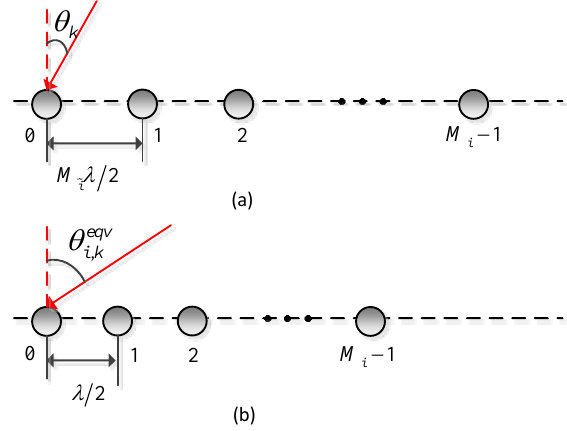
Figure 2. The System model of ( a ) the i th subarray and ( b ) its corresponding equivalent array of the co-prime linear array. θ k is the true DOA for the k th source, and θ eqv